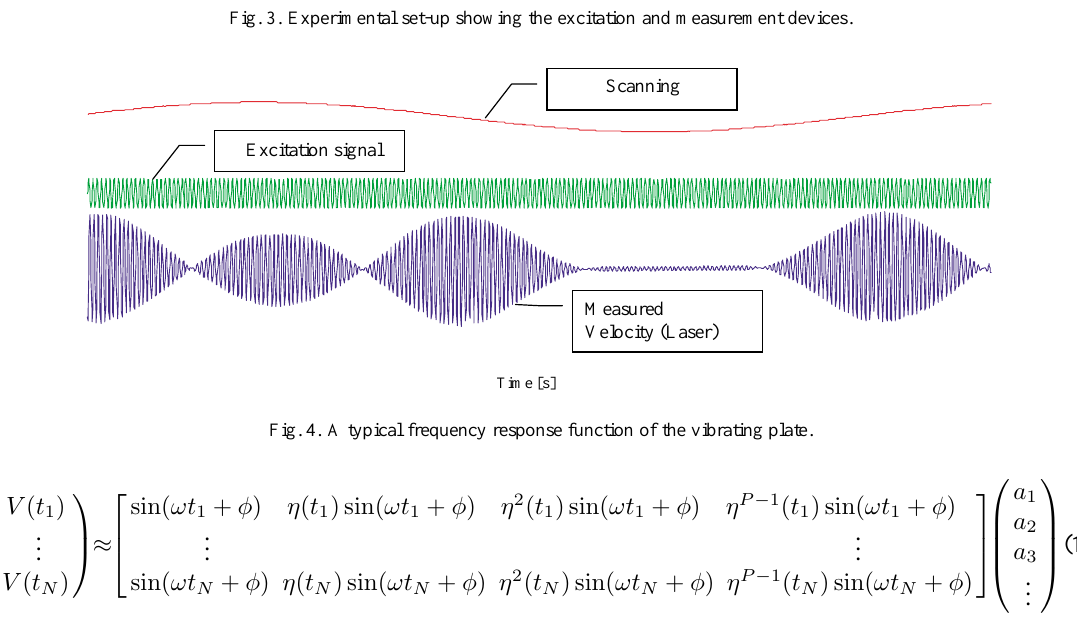
spectrum of the measured laser response is depicted in Fig.